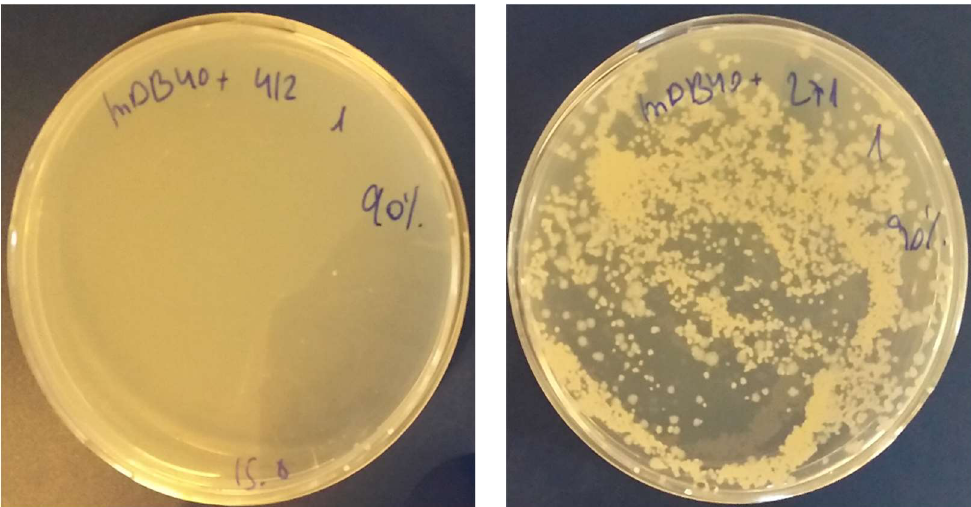
Figure 4. mapB is essential in BCG. mDB40 [ pasteur ΔmapB:zeo, attb:kana:mapB ] was electroporated by either pYUB412 ( attb:hyg , left) or pDB271 ( attb:hyg:mapB , right). Multiple colonies arise with pDB271